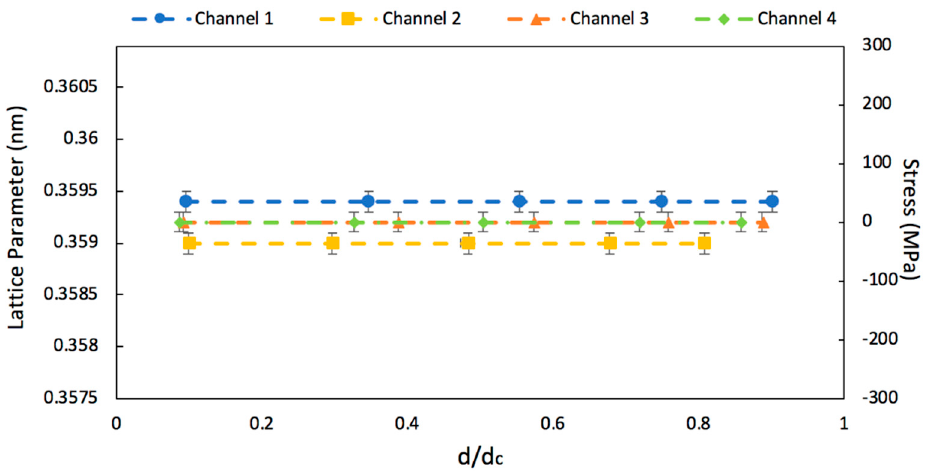
Figure 5. The obtained lattice parameters and corresponding axial stress values in different locations within a dislocation channel. The lattice parameter of an unloaded copper was found to be 0.3592 nm.